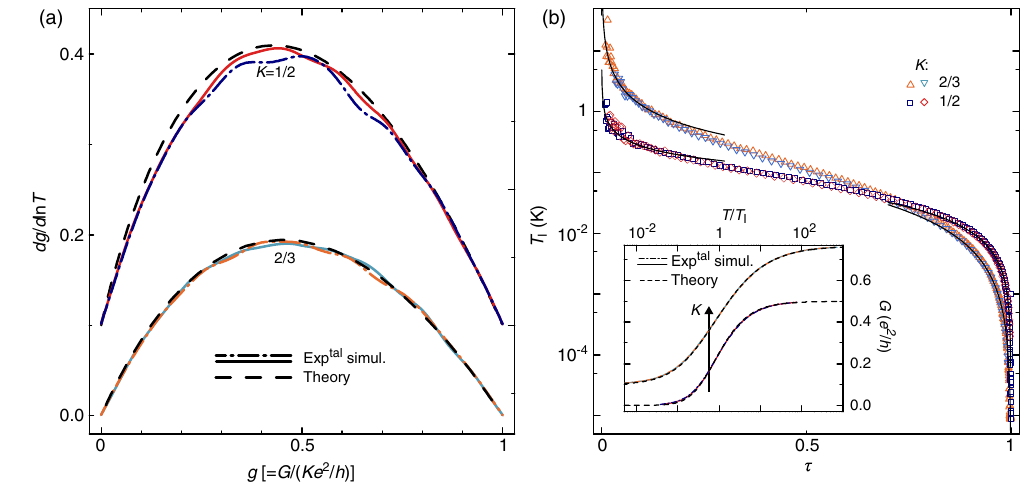
FIG. 6. Reproducibility in equivalent circuit configurations. (a) Renormalization beta function for two physical implementations of the QPC in series with a linear resistance R ∈ f 1 ; 1 = 2 g × h=e 2 . The continuous lines show the same experimental quantum simulations displayed Fig. 2(a), while the dash-dotted lines are obtained with another QPC (at a lower signal-to-noise level). (b) The experimental scaling temperature T (symbols) does not depend on the impurity realization by different QPCs at our experimental accuracy (different I superimposed symbols correspond to different physical realizations of the QPC). Inset: Equivalence of the simulated renormalization T=T flows G (continuous lines, main article data; dash-dotted lines, additional K ð I Þ